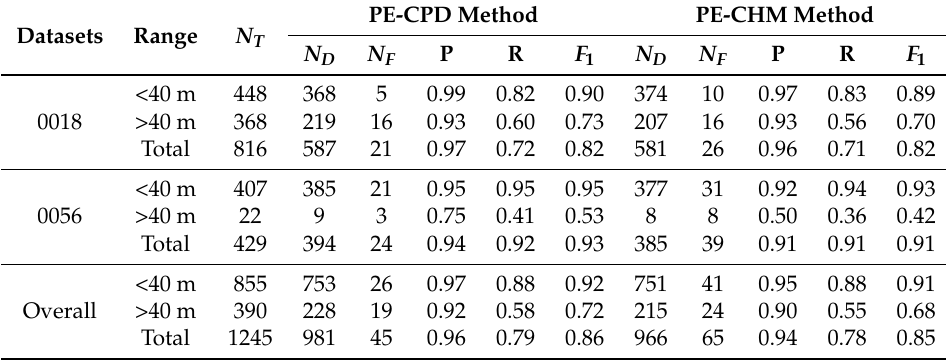
Table 2. Dynamic vehicle detection results by the pose estimation based on coherent point drift (PE-CPD) method and the proposed pose estimation with convex-hull model (PE-CHM)